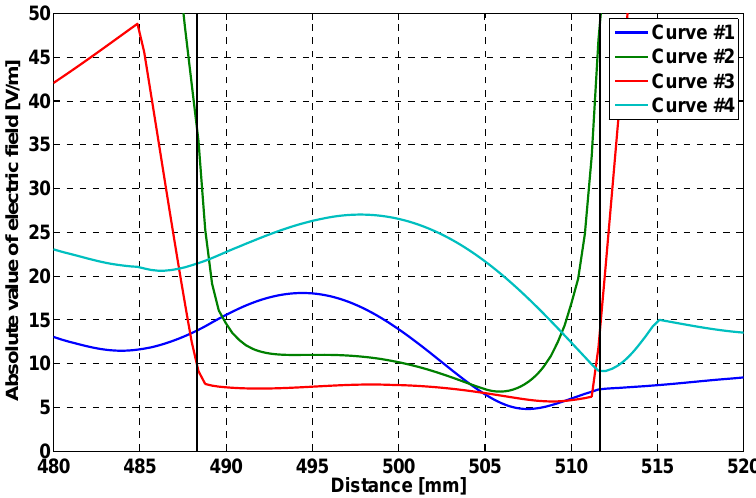
Figure 5. Expanded view of the field inside the bag, for plane wave incidence. The curve number refers to the segments in Figure 2.